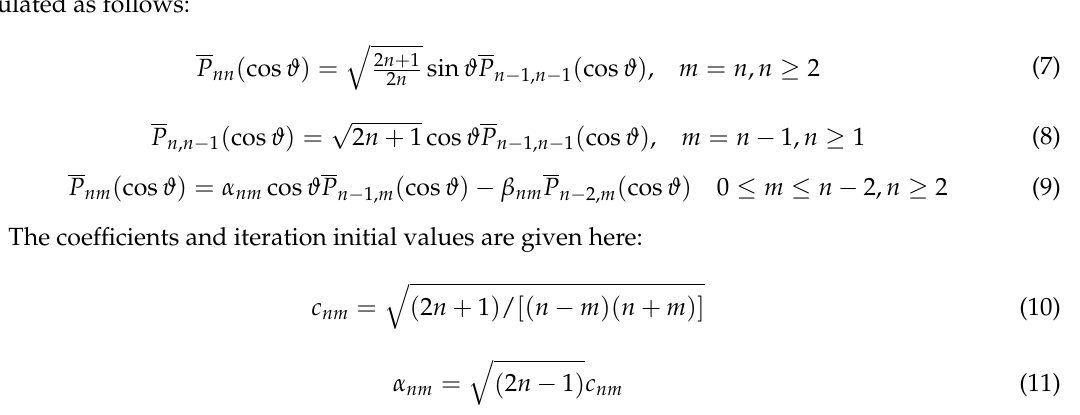
Figure 4. The definition of DOV.